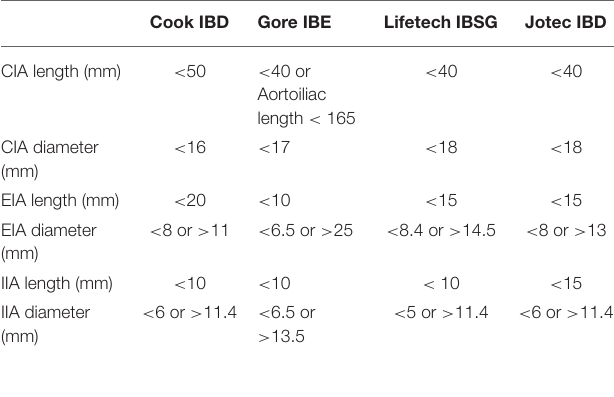
TABLE 1 | Summary of exclusions for the four IBDs based on anatomical characteristics.